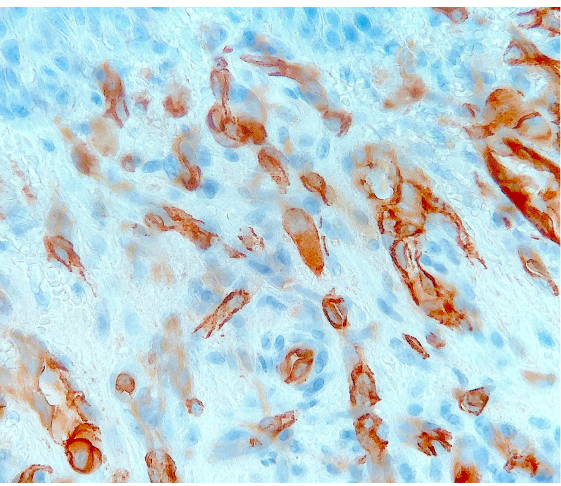
Dermatopathology 2023 , 10 , Figure 5. Occasional (normal) mitoses are seen (haematoxylin–eosin–saffron stain). Note also epithelioid endothelial cells lining vascular lumina.